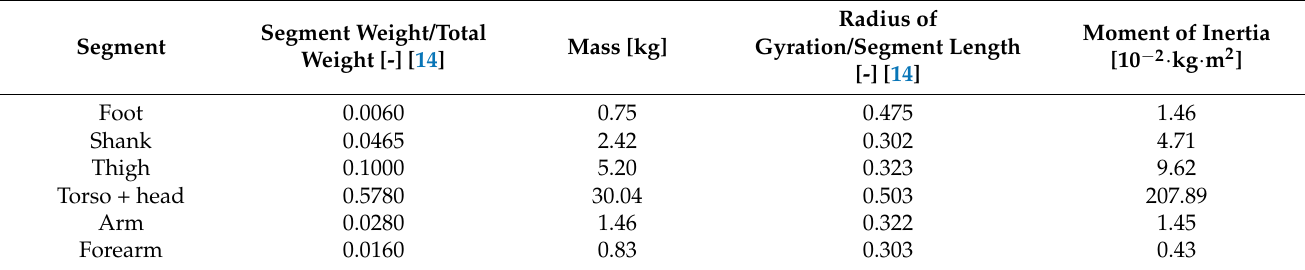
Table 1. Values of mass and mass moments of inertia of particular body segments of the person performing